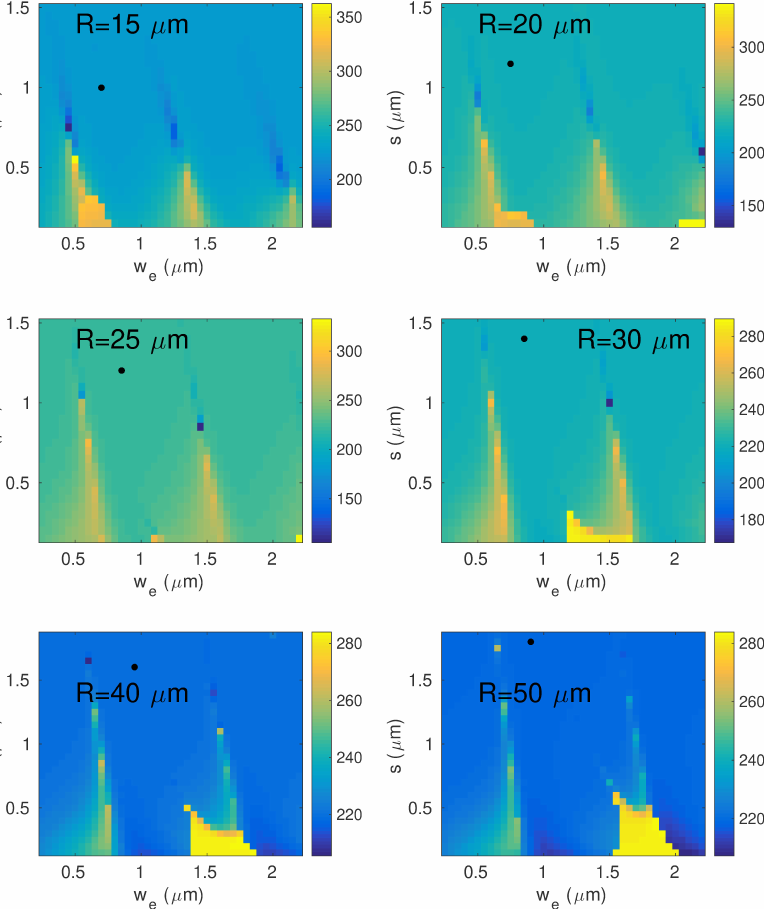
Figure 10. Sensitivity ( ∆ λ res / ∆ ( RIU )) of the principal TE mode for six different values of R : 15 µ m, 20 µ m, 25 µ m, 30 µ m, 40 µ m and 50 µ m at λ = 1550 nm, as a function of the design parameters w e and s . The positions corresponding to the maximal values of a are marked with black spots. Table 1. Single-ring round-trip transmission amplitude factor a and sensitivity S and the corre- sponding values for optimal (Opt.) asymmetric concentric ring geometries for six values of R . The parameters defining the optimized structures, w e and s , are also shown in the table. Results are for the TE-polarized